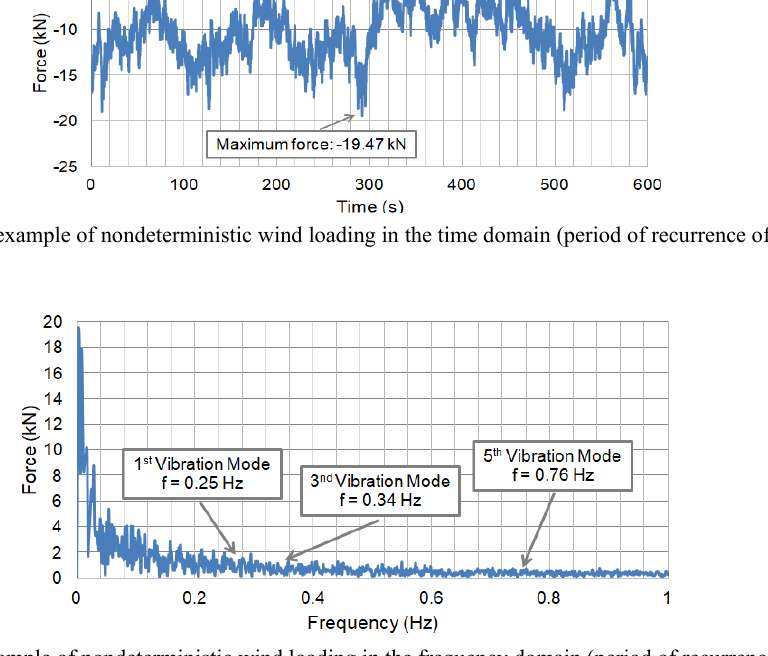
Figure 10. Typical example of nondeterministic wind loading in the frequency domain (period of recurrence of 10